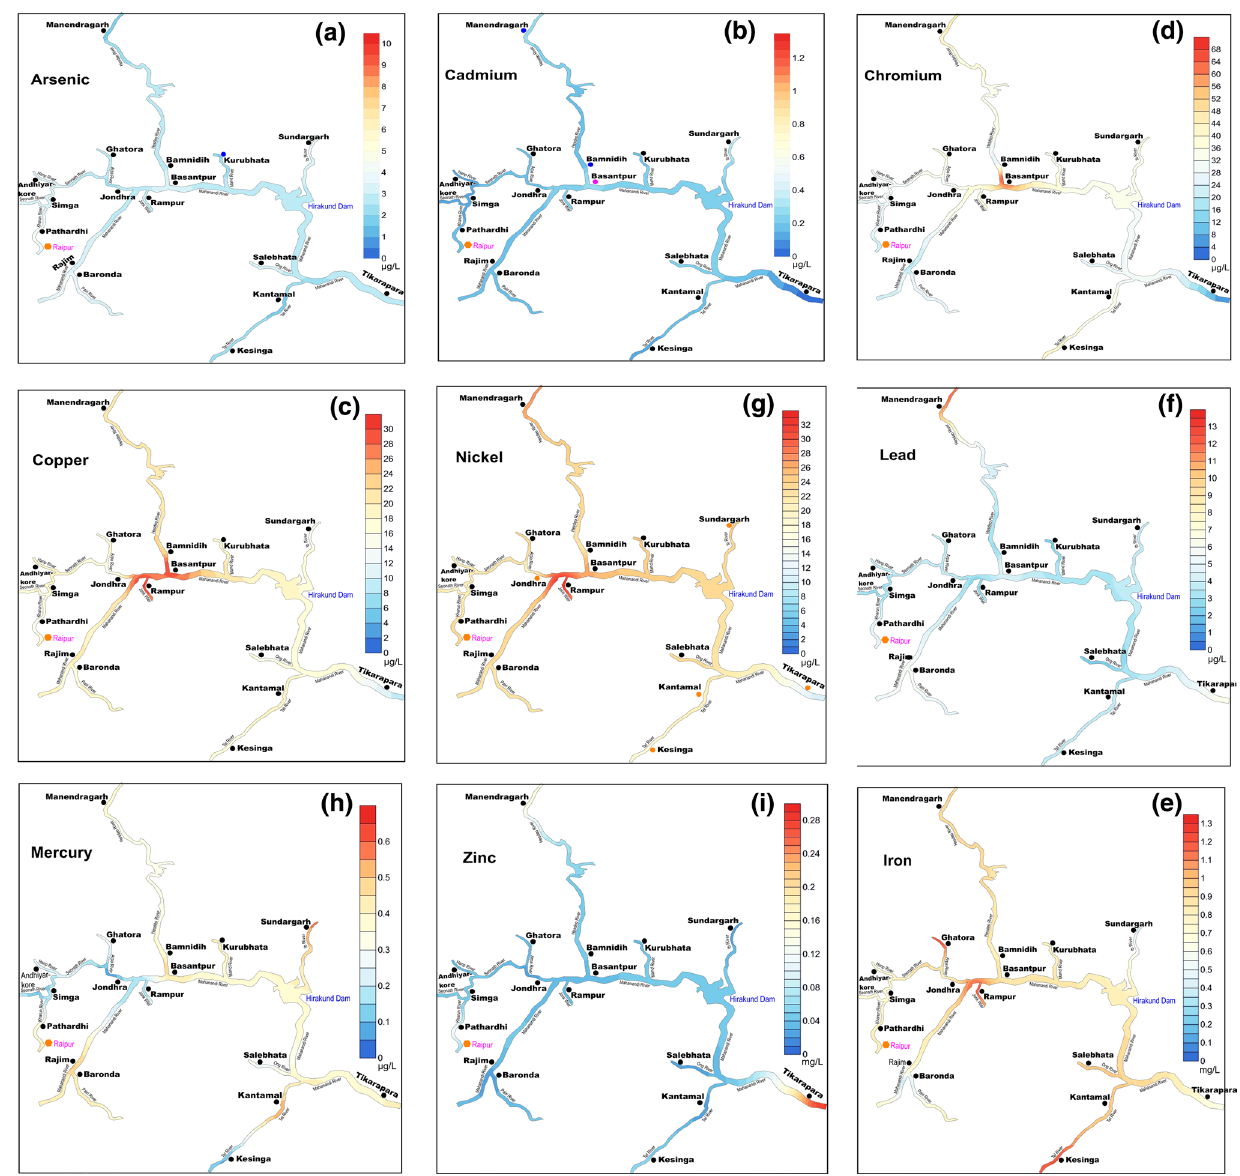
Fig. 3 Contour map diagrams showing the concentration of the specified trace elements a As, b Cd, c Cr, d Cu, e Ni, f Pb, g Hg, h Zn, and i Fe at various water sample locations across Mahanadi River